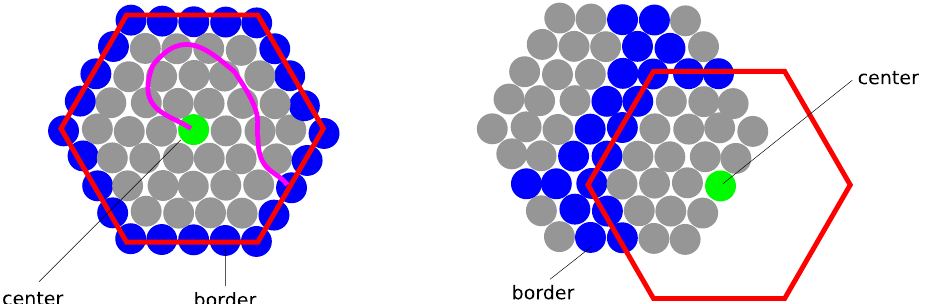
Figure 7. Generation of a new place cell: the center of the grid module defines a set of grid cells as border grid cells. When reaching a border grid cell, a new place cell is added, and associated with this border grid cell, which then becomes the new center of this